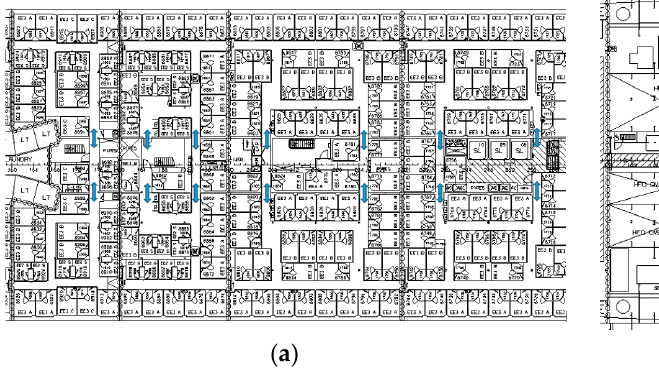
Figure 21. Cross-flooding restriction sources. ( a ) Deck 1, ( b ) tank top deck.